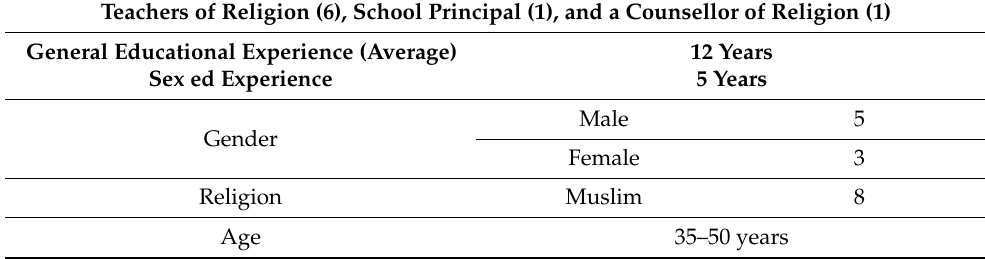
Table 1. Background characteristics of respondents that were